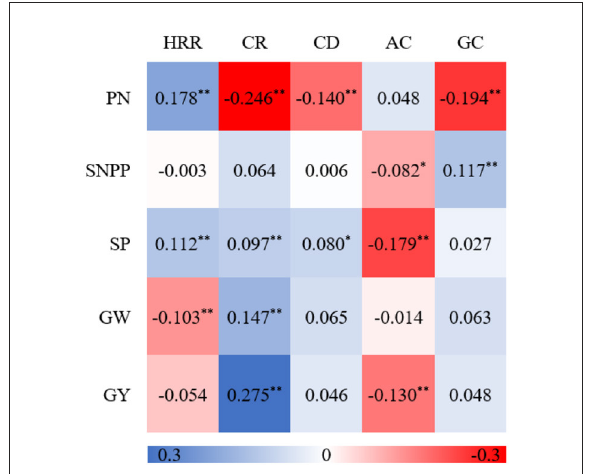
FIGURE2 Correlation coefficient between grain yield and quality of high-quality rice from 2007 to 2017 ( n = 710). *Correlation is significant at the 0.05 level, while ** correlation is significant at the 0.01 level (two-tailed). PN, panicle number; SNPP, spikelet number per panicles; SP, seed-set percentage; GW, grain weight; GY, grain yield; HRR, head rice rate; CR, chalkiness rate; CD, chalkiness degree; AC, amylose content; GC, gel